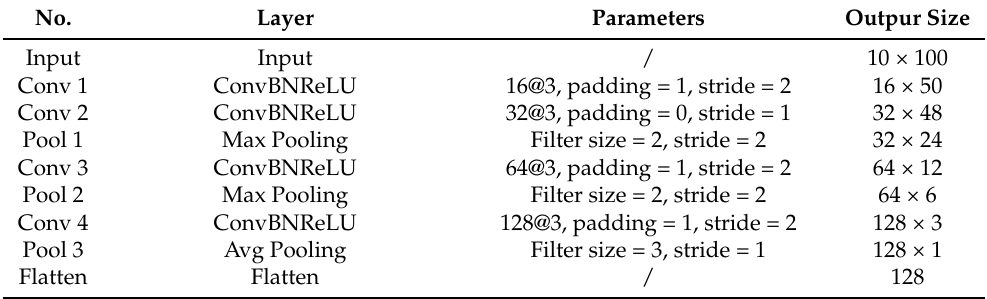
Table 4. Details of the 1DCNN backbone.